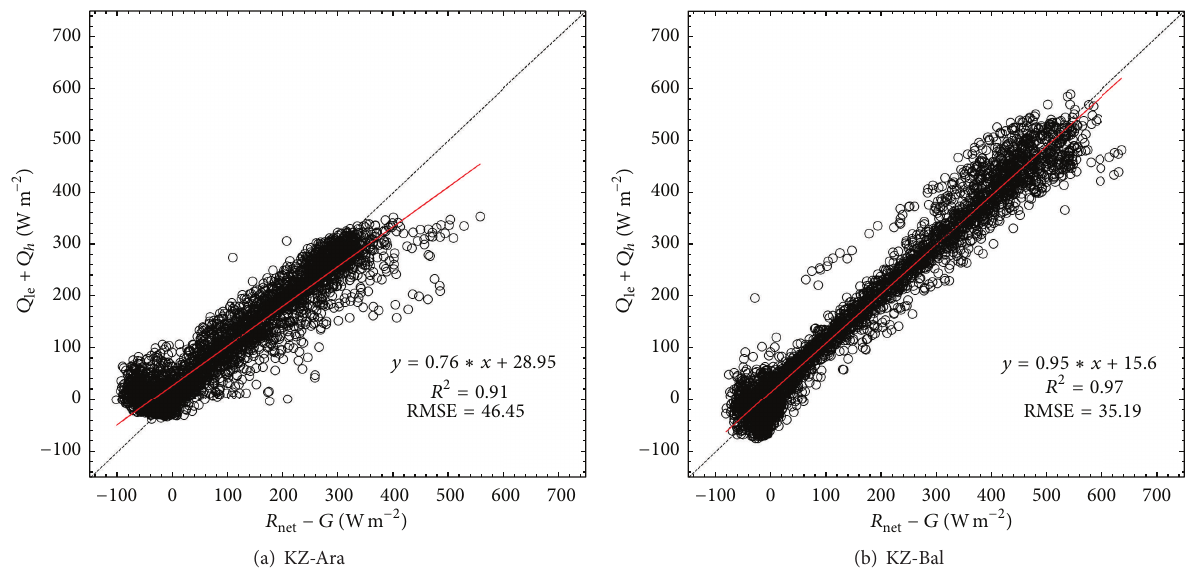
Figure 2: Energy balance closure at the KZ-Ara site and the KZ-Bal site. The slope of the fitted line represents energy closure ratio and 𝑅 2 is the coefficient of determination. RMSE (Wm −2 ) is the root mean square error. The energy fluxes include sensible heat flux ( 𝑄 ℎ ), latent heat flux ( 𝑄 le ), net radiation ( 𝑅 net ), and ground heat flux ( 𝐺